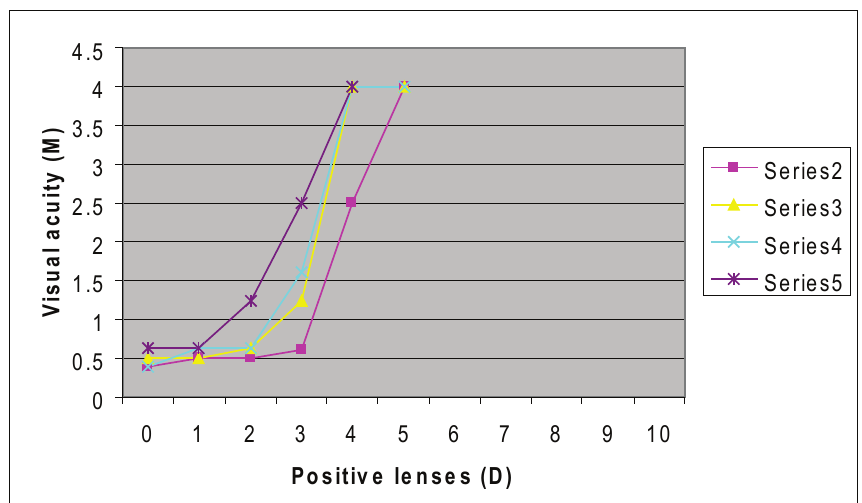
Figure 4. Effect of positive lenses on visual acuity while viewing a near acuity chart at 0.4 m without a pinhole and illumination of 1 lux.